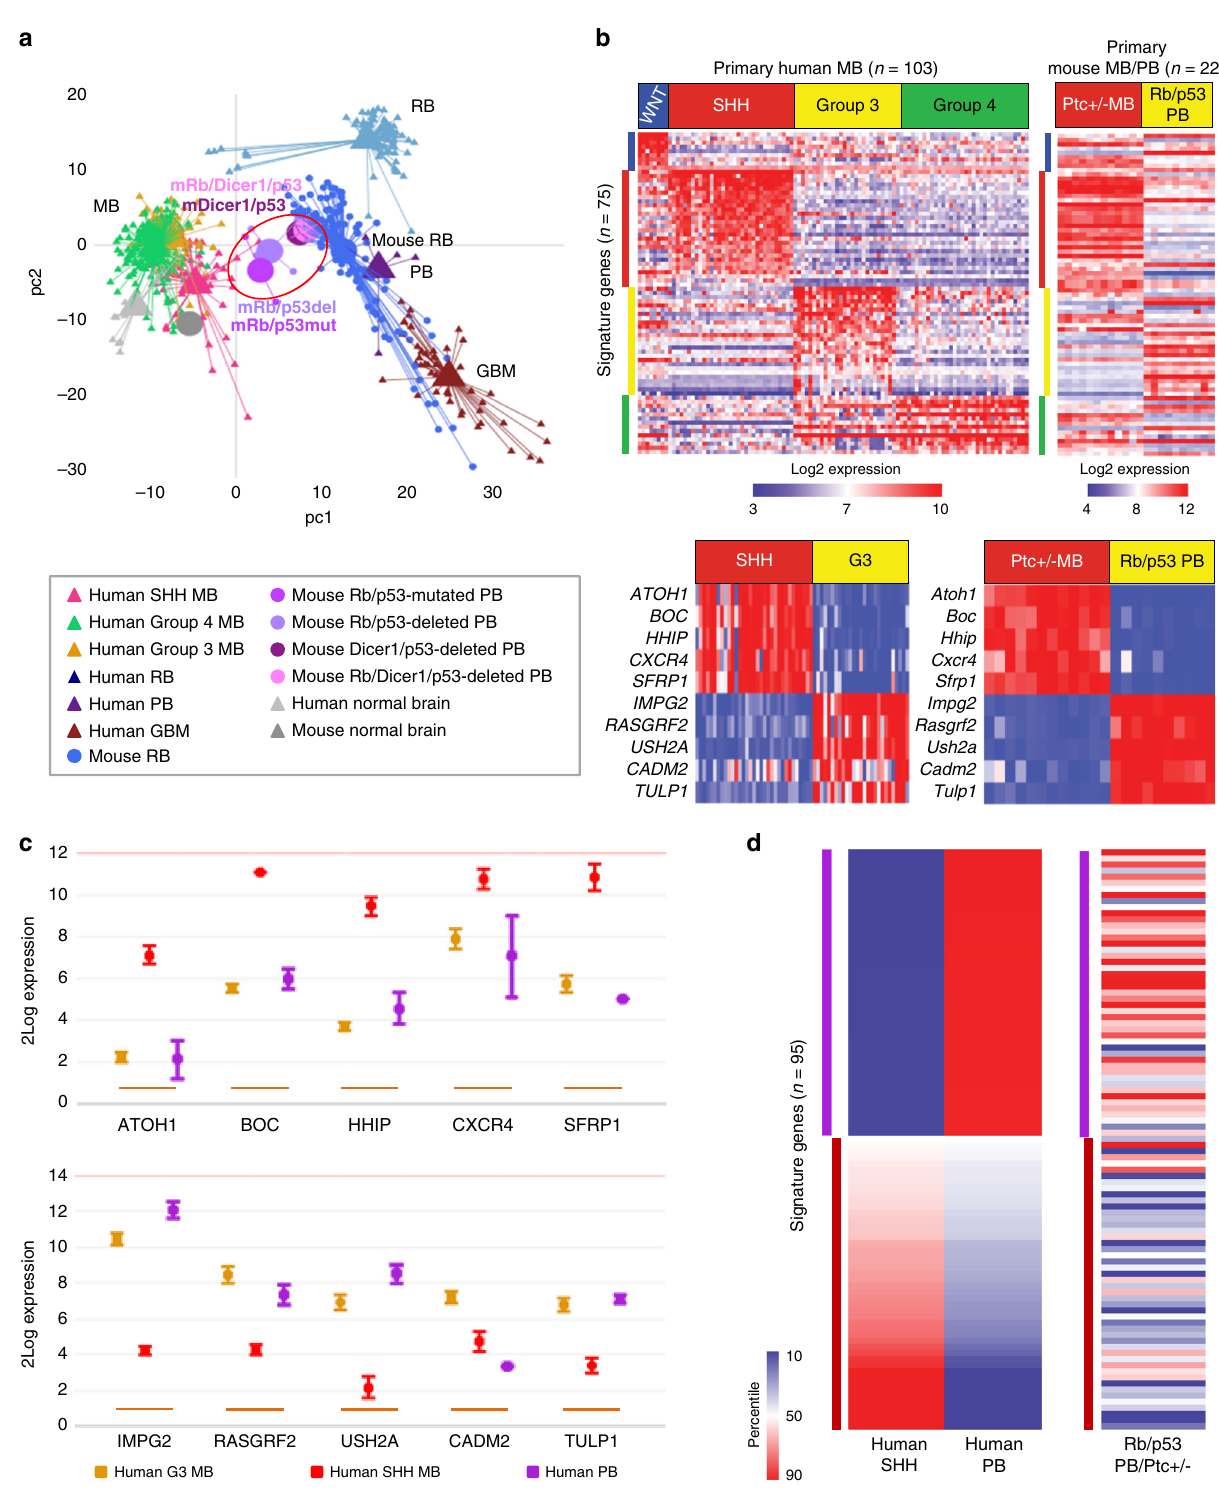
Fig. 2 Mouse pineoblastomas cluster close to human pineoblastoma and medulloblastoma. a GSEA-PC analysis of mouse Rb/p53-deleted ( n = 12), Rb/ p53-mutated ( n = 5), Dicer1/p53-deleted ( n = 3) and Rb/Dicer1/p53-deleted ( n = 3) pineoblastomas (circled), showing close clustering with mouse retinoblastoma (mouse RB), human PB and medulloblastoma (MB) but not glioblastoma (GBM). A 3-D image is shown in Supplementary Fig. 3. b Top, 75 signature genes (depicted in supplementary Table S1) were used to classify human medulloblastoma into 4 subgroups (left) and compare mouse Rb/ p53-deleted PBs with Ptc + / − mouse model of SHH MBs (right). Bottom, expression of top 10 signature genes from human SHH vs group 3 MB subgroups (left), and from mouse Ptc + / − MB vs Rb/p53-deleted PBs (right), showing similar relative expression. c Expression of top 10 signature genes (mean ± SD) identi fi ed above in human PBs, group 3 ( n = 7) and SHH ( n = 4) MBs in an independent dataset. d 95 signature genes (listed in supplementary Table S1) used to differentiate between human SHH MB and human PB. Similar relative expression of the same 95 signature genes in Rb/p53-deleted PBs, normalized to expression levels in the Ptc + / − mouse model of SHH